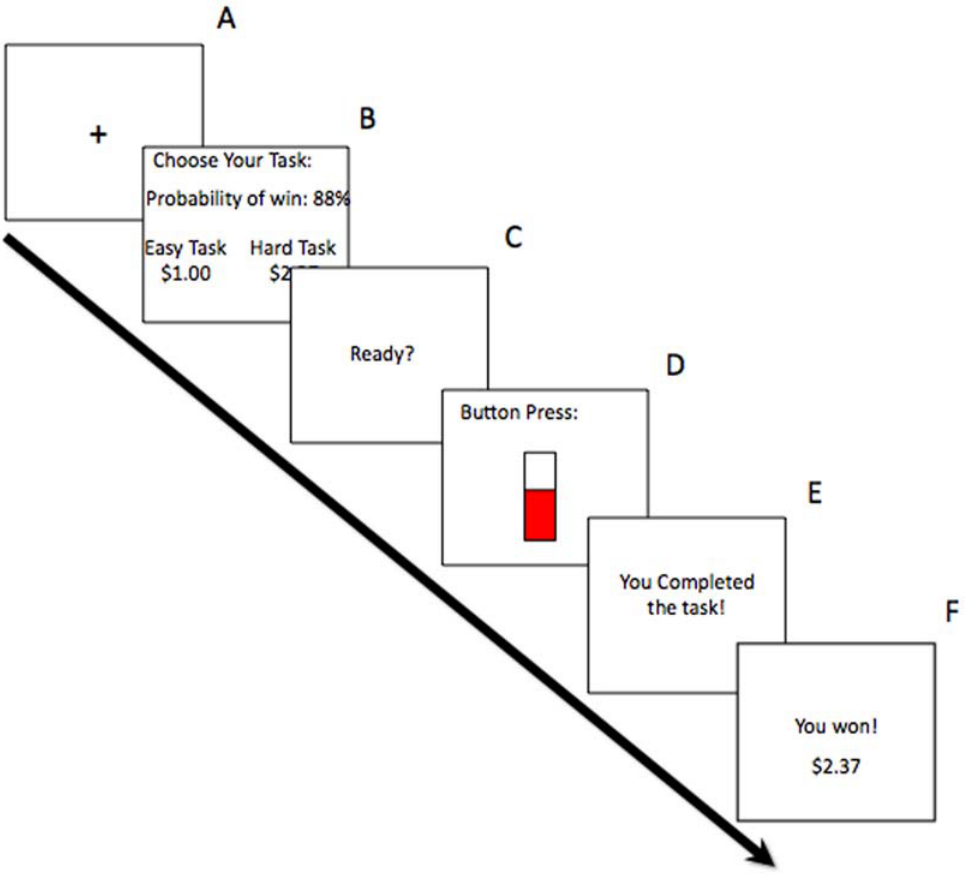
Figure 1. Schematic diagram of a single trial of the Effort Expenditure for Rewards Task (‘EEfRT’). A) Subjects begin by seeing a 1s fixation cue. B) 5s choice period in which subjects are presented with information regarding the reward magnitude of the hard task for that trial, and the probability of receiving any reward for that trial. C) 1s ‘‘ready’’ screen. D) Subjects make rapid button presses to complete the chosen task for 7s (easy task) or 21s (hard task). E) Subjects receive feedback on whether they have completed the task. F) Subjects receive reward feedback as to whether they received any money for that trial.